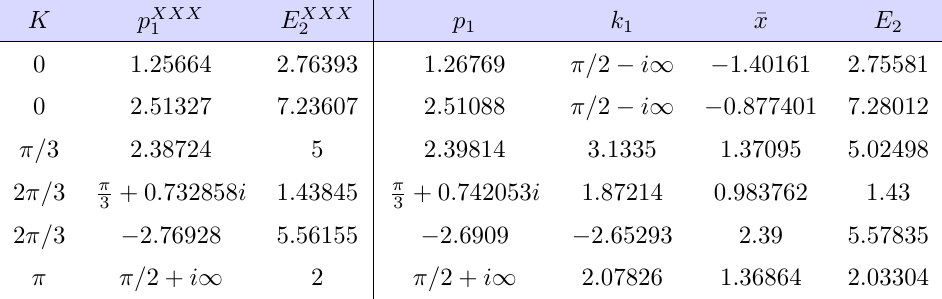
Table 4 . Length-6, κ = 0 . 9 untwisted XZ chain: the momenta appearing in the untwisted X - vacuum XZ -sector 2-magnon wavefunction for the case L = 6 , κ = 0 . 9 . The corresponding momenta and energies for the XXX model at κ = 1 are given for comparison. The p as p = K − p and similarly for k . We have chosen the p momenta to be the ones that are closest 2 1 2 to the corresponding momenta for XXX . As explained in the main text, ¯ x is the proportionality constant between the A and B